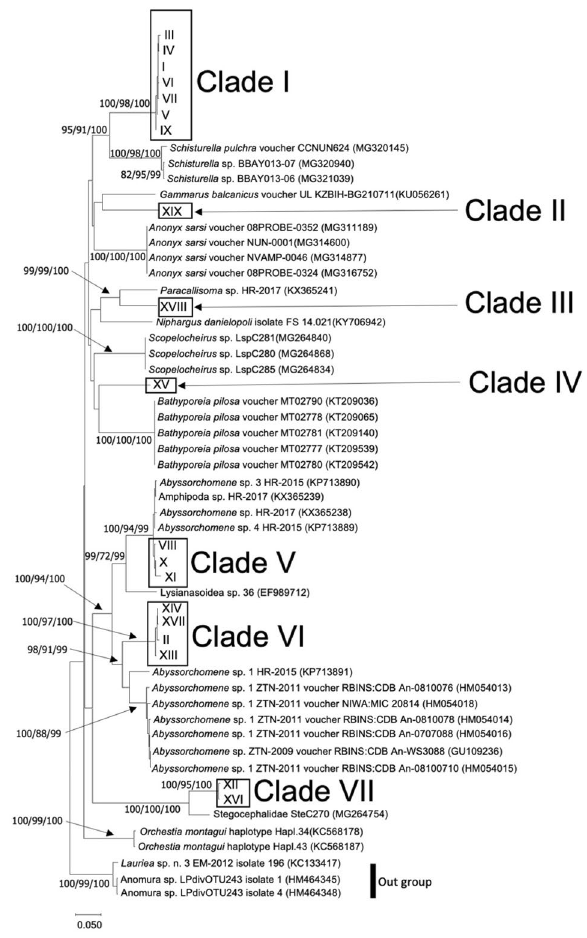
Figure 5. Molecular phylogenetic tree of amphipod species. Numbers indicate bootstrap values of neighbor- joining and maximum likelihood methods (only those > 70% are shown) and Bayesian posterior probabilities (shown as NJ/ML/BI). Boxes show clades containing the haplotypes we obtained. Scale indicates 0.05 substitutions per